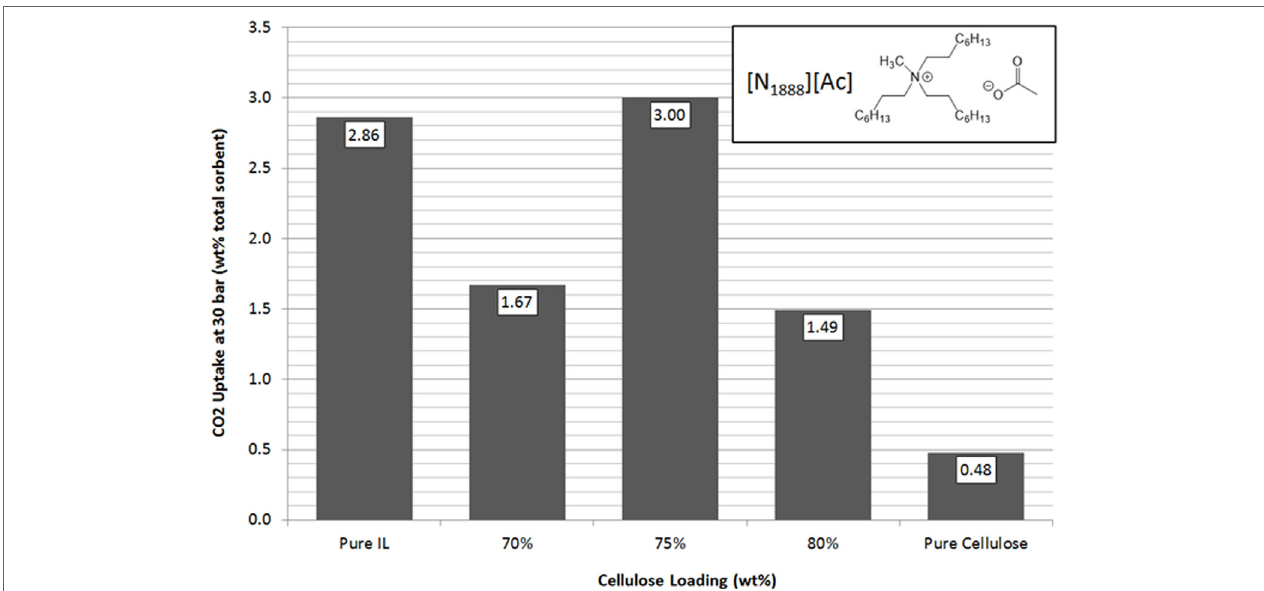
FigUre 9 | Trends in total sorbent CO 2 uptake at 30 bar of [N 1888 ][Ac] as a function of cellulose loading at room